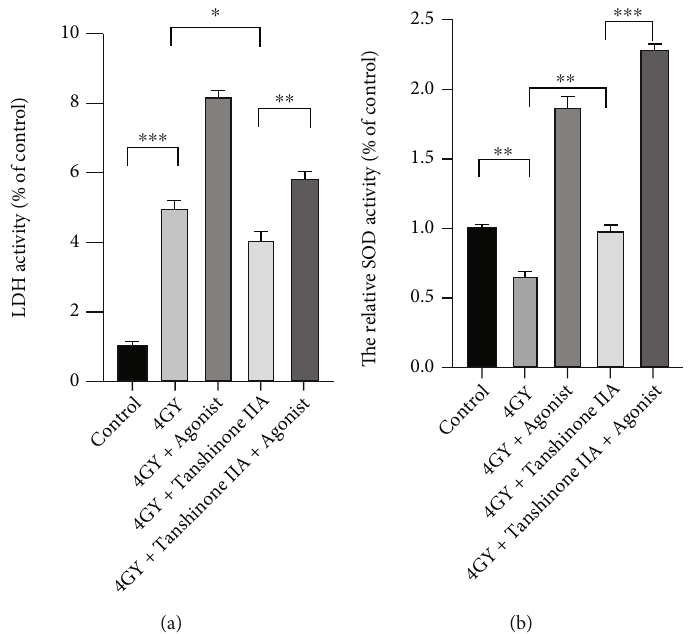
Figure 2: Radiation and tanshinone IIA e ff ects on cardiomyocytes were detected by measuring LDH release (a) and SOD activity (b). The means ± SD are presented for each result ( n = 3 ). ∗∗∗ P < 0 : 001 , ∗∗ P < 0 : 01 , and ∗ P < 0 : 05 . LDH: lactate dehydrogenase; SOD: superoxide